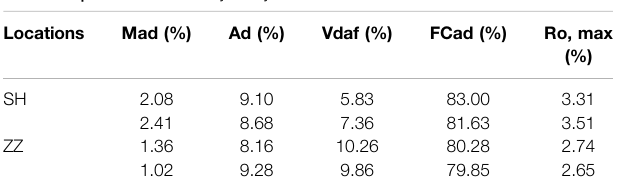
TABLE 1 | No.3 coal industry analysis